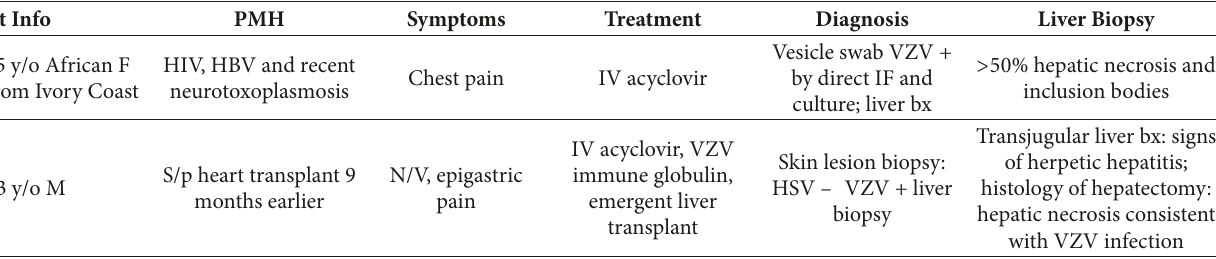
Table 1: Case reports: survivors [2, 3].